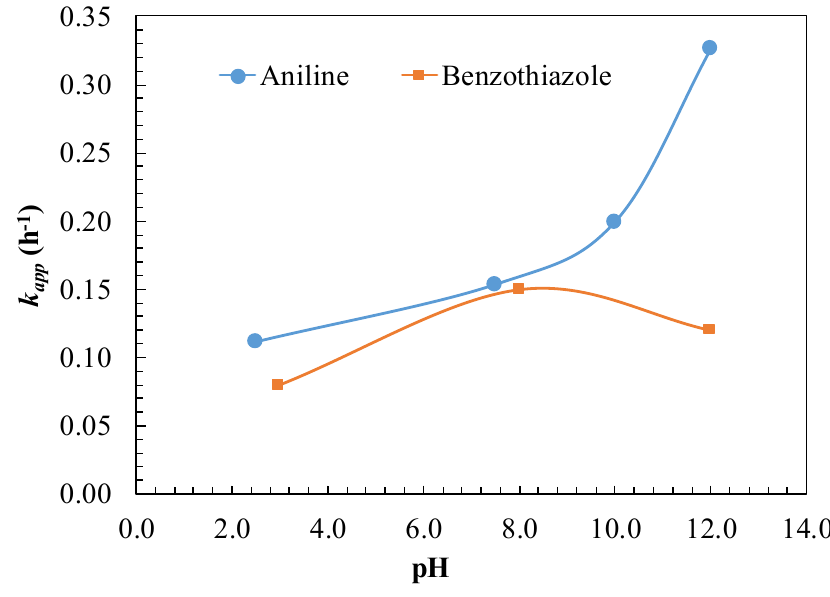
Figure 7. Pseudo-first order kinetic constants, k app , at different pHs, for photocatalytic degradation of aniline or benzothiazole with only TiO 2 -supported catalyst. Experimental conditions: C 0 = 22.0 mg L −1 ; T = 25.0 °C; P = 1.0 atm.